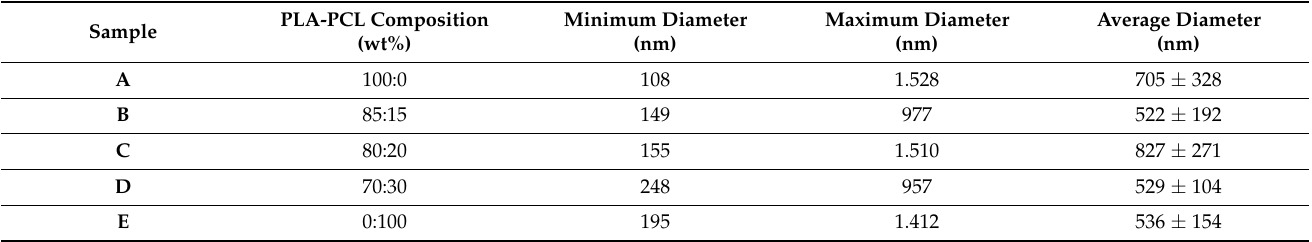
Table 2. Compilation of fiber diameter of the